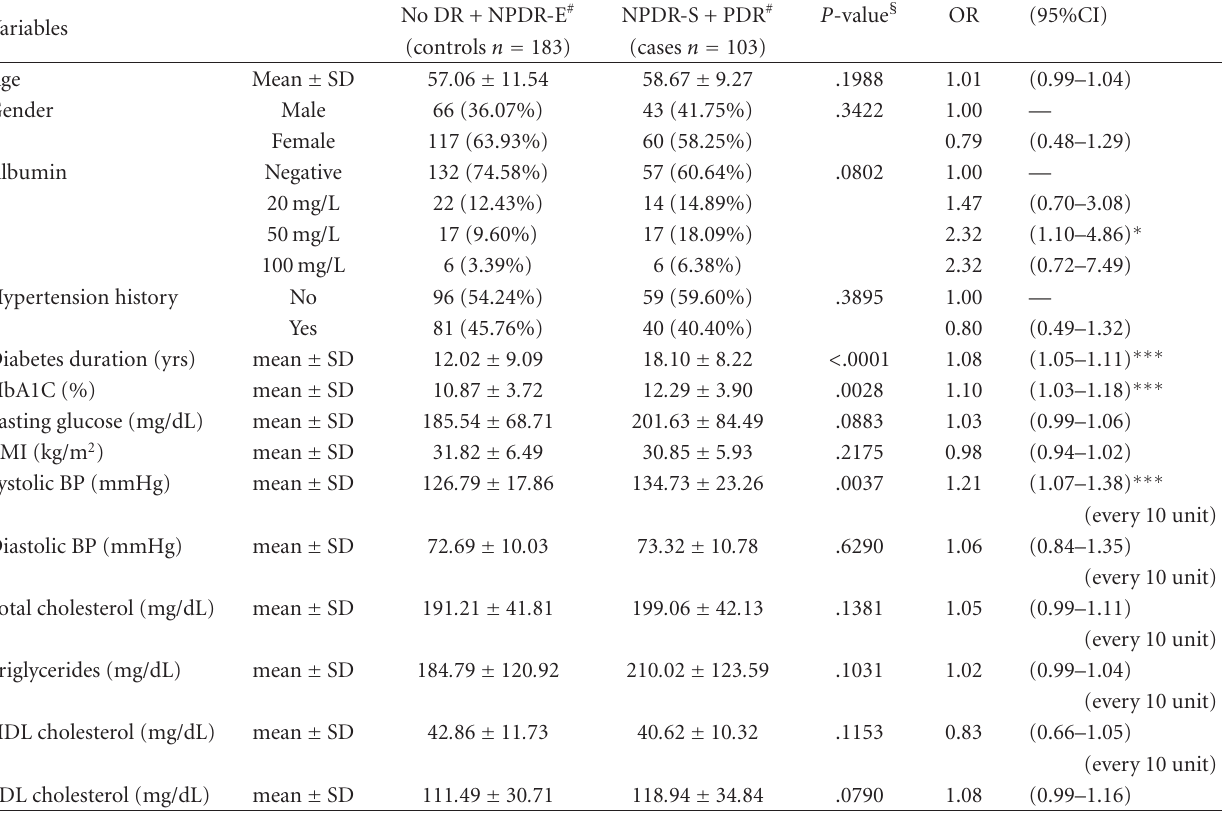
Table 1: Basic characteristics of Mexican-Americans with type 2 diabetes from Starr County,